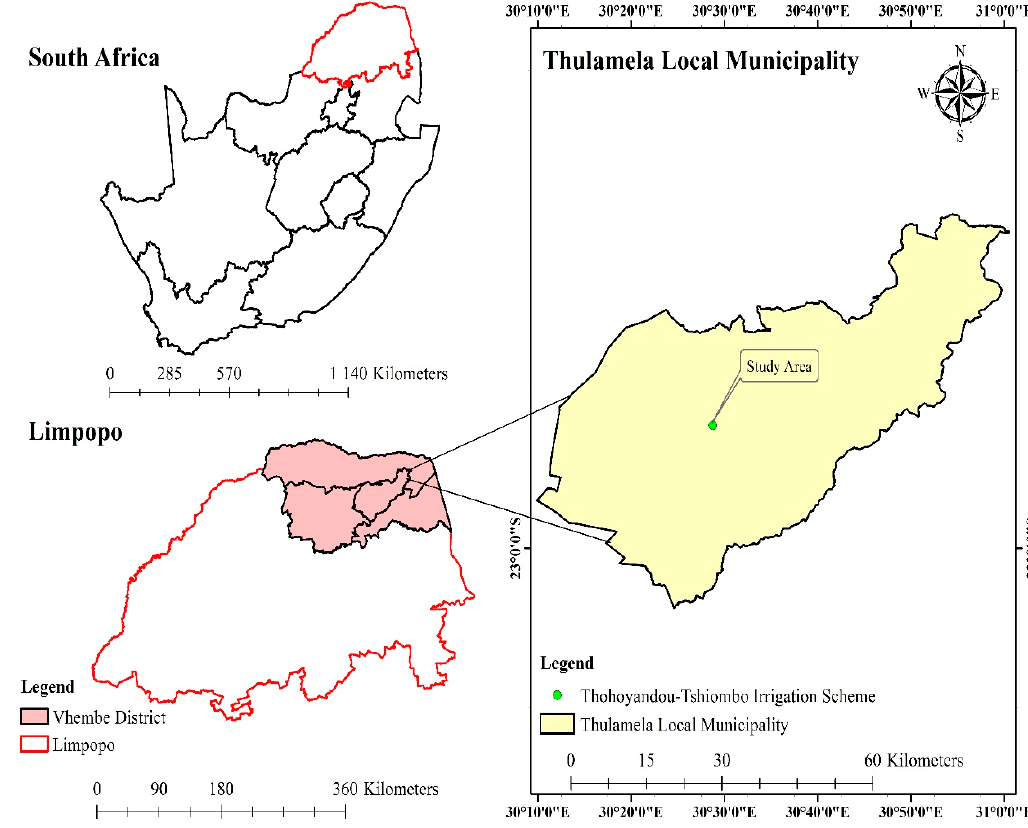
Figure 1. Study site, Limpopo Province (Source: Author).